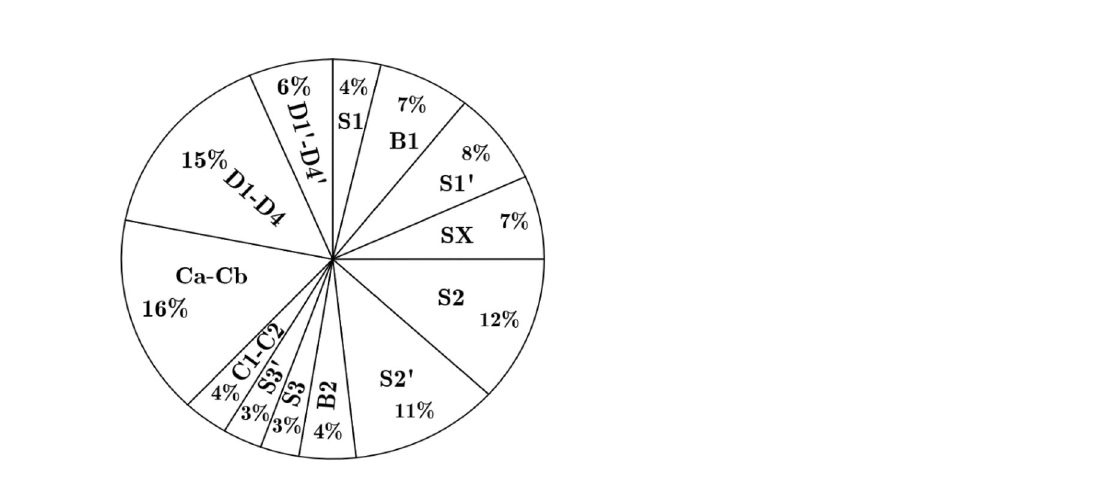
Figure 6. Power loss